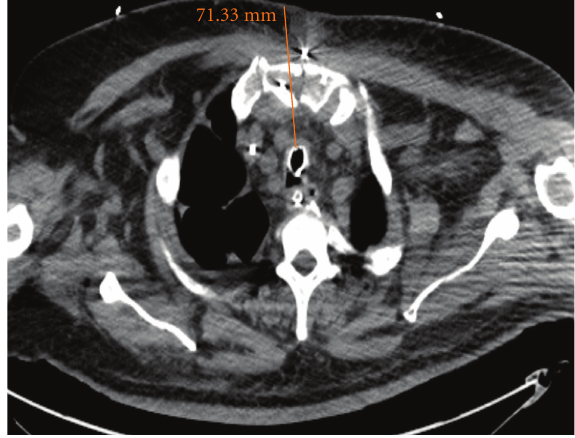
Figure 2: CT of an obese patient. Due to the distance of the trachea from the anterior surface of the neck ( > 7cm from the skin), the trachea could be reached reasonably easily and safely from a point under the sternum.